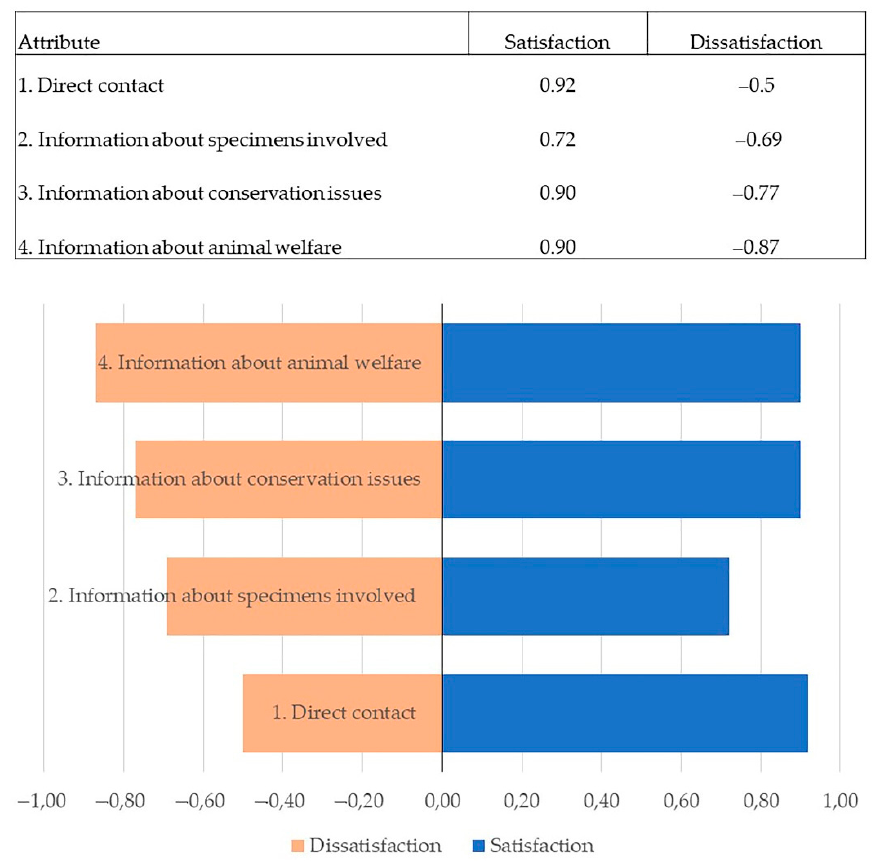
Figure 2. Customer Satisfaction coefficient (CS) calculated for the four attributes of the interaction activity “giraffe feeding”. Evaluating the causes for satisfaction (right part of the graphic, blue stripes): The closer the value is to +1, the more the presence of that attribute influences respondents’ satisfaction. On the left side of the figure (orange stripes): The closer the value is to − 1, the more that attribute influences respondents’ dissatisfaction if not present in the interaction.